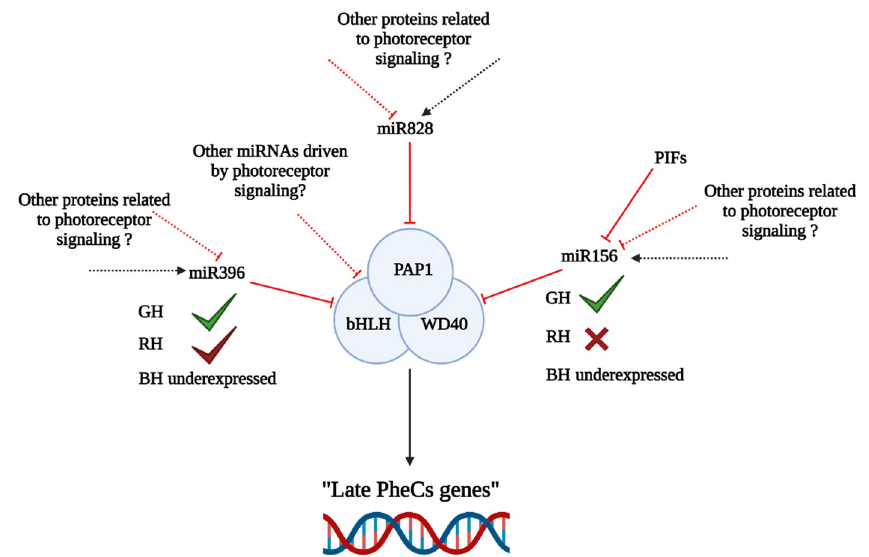
Figure 10. Schematic representation of possible effects of miRNAs on the MBW complex, which is responsible for the regulation of “late PheC genes”—presence (check), absence (cross), or downregulation of corresponding miRNAs under specific light conditions are indicated; full lines were validated by articles cited in the text above; dashed lines indicate possible alternative ways of regulation. Solid lines represent known interactions, whereas dashed lines indicate presumed alternative methods of regulation (not yet confirmed) (black—induction/upregulation; red—inhibition/downregulation). BH (blue), RH (red), and GH (green) light of high intensity; 400 µmol m − 2 s − 1 .